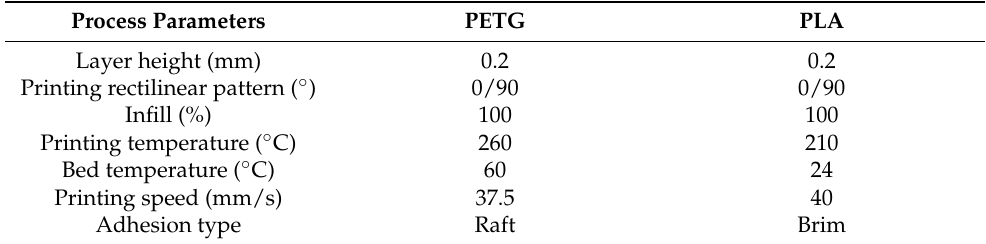
Figure 1. Experiment setup. Table 1. Process parameters for printing specimens with polyethylene terephthalate glycol (PETG) and polylactic acid (PLA).